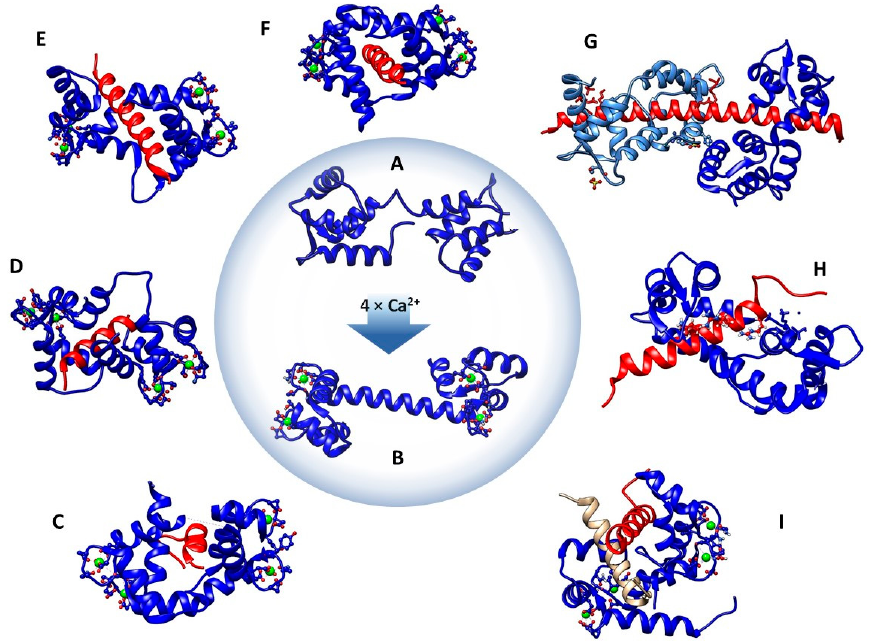
Figure 1. All CaM structures shown in blue, and CaMBPs are shown in red or tan. ( A ). Apo-CaM (PDB ID 1cfd) with central helix unwound/extended. ( B ). Holo-CaM (PDB ID 4bw8) with 4 Ca 2+ ions in EF-Hand sites 1–4. ( C ) . Ca 2+ /CaM/MARCKS (myristoylated alanine-rich C kinase substrate) complex (PDB ID 1iwq). The N-lobe of CaM is not involved in binding [10]. ( D ). Ca 2+ /CaM/CaMKII α complex (PDB ID 1cm1) exhibiting 1-5-10 binding mode with collapsed CaM [11]. ( E ). Ca 2+ /CaM/RyR1 complex (PDB ID 2bcx) exhibiting unusual 1-17 binding mode with collapsed CaM [12]. ( F ). Ca 2+ /CaM bound to peptide analog of CaM-binding region of chicken smooth muscle myosin light-chain kinase (PDB ID 1cdl) [13]. ( G ). Apo-CaM/Myosin V 2:1 complex (PDB ID 2ix7). Each CaM C- lobe is partially open to grip the first part of the IQ motif (IQxxxR), while the closed N-terminal lobes interact weakly with the second part of the motif (GxxxR) [14]. ( H ). Apo-CaM (blue) bound to zebrafish IQCG protein (red) (PDB ID 4lzx), exhibiting lower affinity than the Ca 2+ -bound state [15]. Sidechain interactions with CaM include residues highlighted in bold from the IQCG sequence 400-410 ( LQ AWW RG TMI R ). ( I ). Ca 2+ /CaM/Glutamate decarboxylase chains B and C (PDB ID 1nwd) [16].